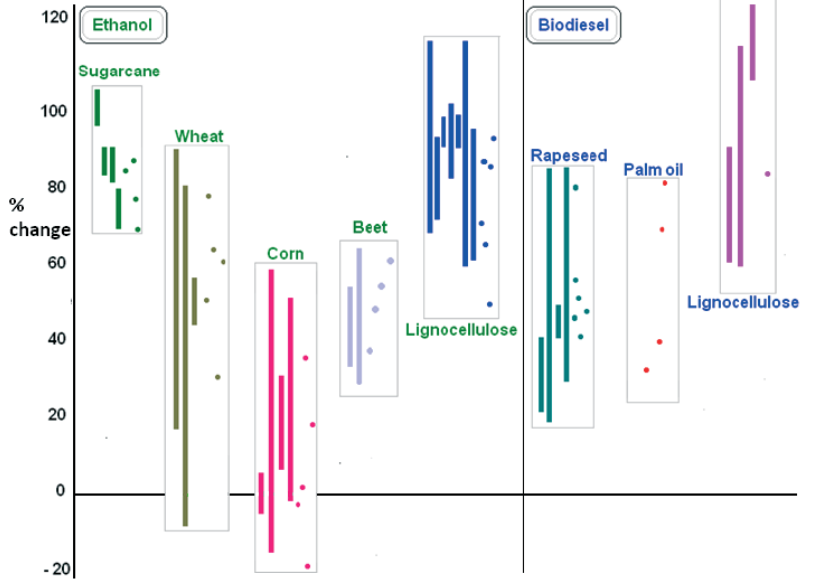
Figure 76. Life-cycle emissions for 1 st - (left) and 2 nd -generation (right) (© 2008 OECD/IEA, reproduced from [328] with permission). Y-axis values are relative to petrol and mineral (non-bio) diesel. A value of 0 means no change in emissions, >100% means net sequestration. Data shown do not include emissions from land use